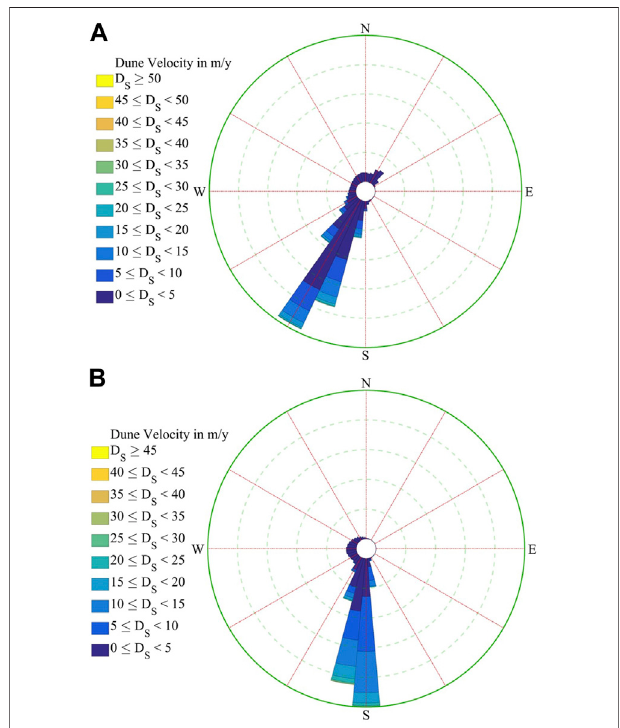
FIGURE 5 | Sand roses illustrating the relationship between dune migration rates and migration direction for active dune areas in the Bodélé Depression (A) and the northwestern dune fi eld (B)